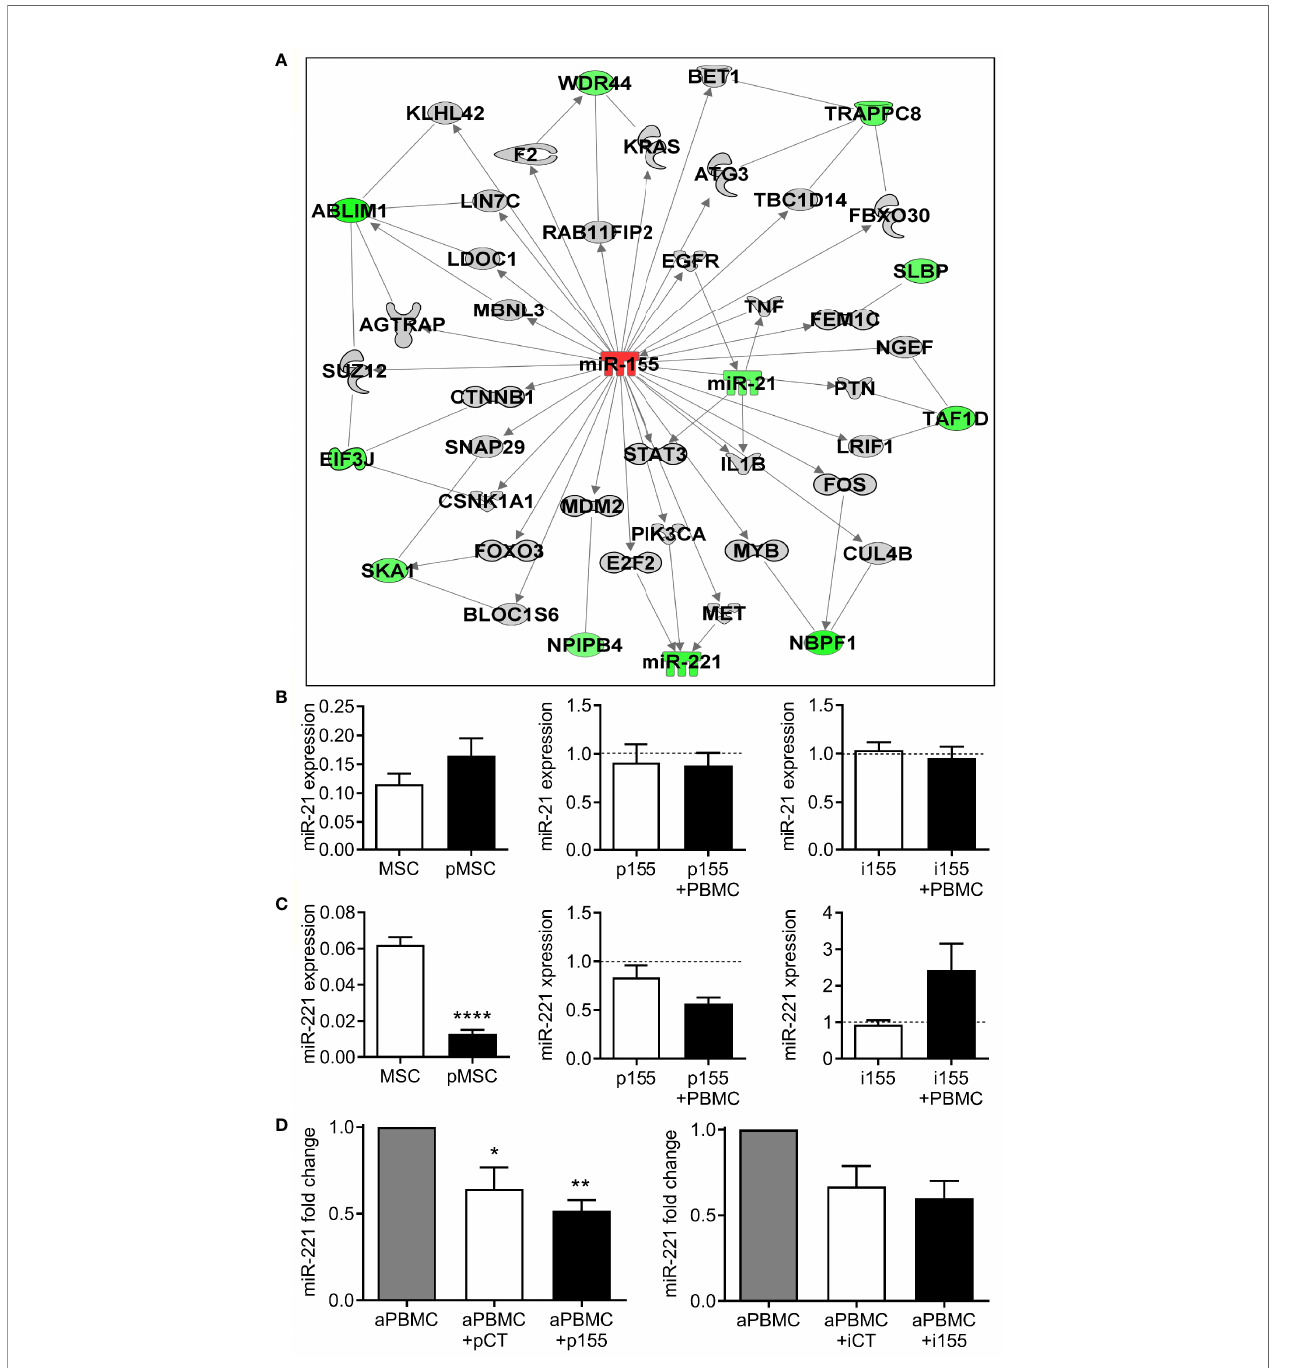
FIGURE 7 | miR-221 is indirectly modulated by miR-155. (A) Integration of miRNA-targets following miR-155 over-expression. Green and red shapes represent genes/miRNA down- and up-regulated, respectively and grey shapes are other genes, not modulated in the transcriptomic analysis, but with putative links. Solid lines mean direct or putative interaction. (B) Mean relative expression ± SEM of miR-21 in naïve MSCs and in pMSCs primed by coculture with aPBMCs (MSC+PBMC) (n=11; left panel) and in MSCs transfected with premiR-155 (p155; n=4; middle panel) or miR-155 inhibitor (i155; n=3; right panel) and cultured alone or with PBMCs. Expression is normalized to MSCs transfected with control premiRNA (pCT) or miRNA inhibitor (iCT) (dash line). (C) Mean expression ± SEM of miR- 221 in naïve MSCs and in MSCs primed by coculture with aPBMCs (MSC+PBMC) (n=11; left panel) and in MSCs transfected with p155 (n=4; middle panel) or i155 (n=3; right panel) and cultured alone or with PBMCs. Expression is normalized to MSCs transfected with control premiRNA or miRNA inhibitor (dash line). (D) Mean expression ± SEM of miR-221 in aPBMCs when cultured alone or with MSCs transfected with control premiRNA (pCT) or p155 (n=4; left panel) or with control miRNA inhibitor (iCT) or i155 (n=3; right panel). Statistical analysis used paired-t test (left panels in B, C ), Wilcoxon unpaired signed rank test ( D and middle and right panels in B, C as compared to pCT or iCT) with *p < 0.05; **p < 0.01; ****p <